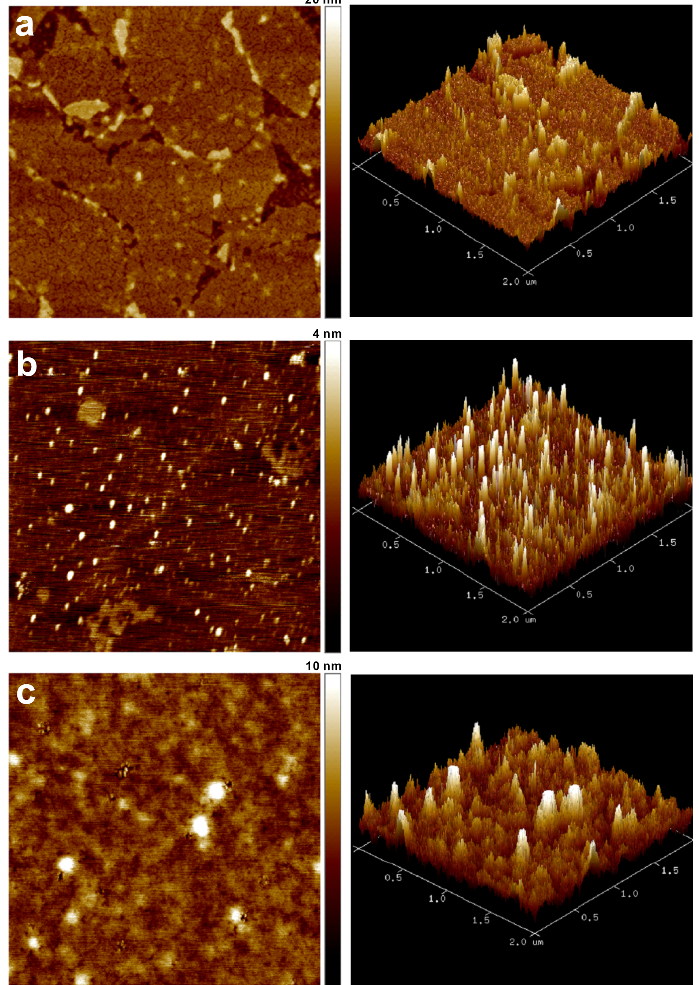
Figure 4. AFM (left) topographic and (right) 3D images of different layer-by-layer fabricated mica. The topmost layer in each image is ( a ) b-PM, ( b ) HbA0 aptamer and ( c ) HbA0: Scan size: 2 μ m.